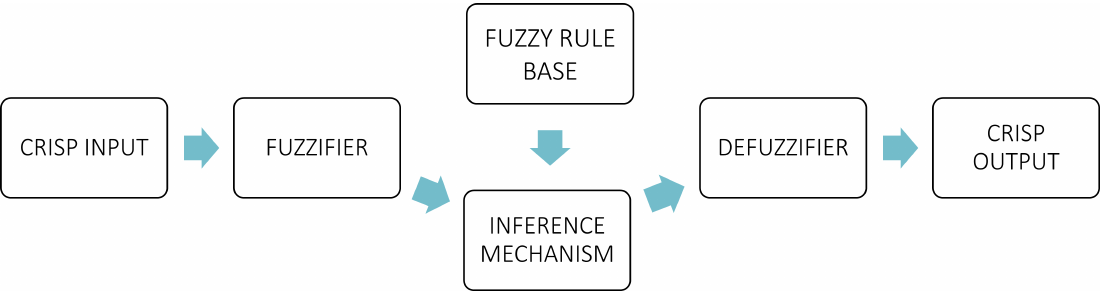
Figure 10. Generic structure of a fuzzy